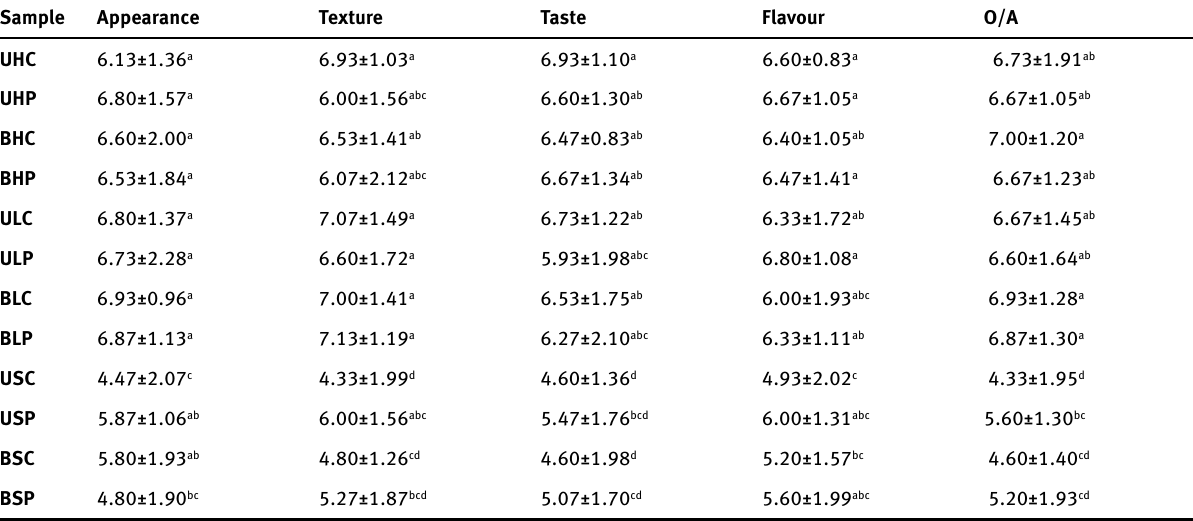
Table 2: Sensory Evaluation of ‘amala’ from Cardaba Banana and Plantain Flour Sample